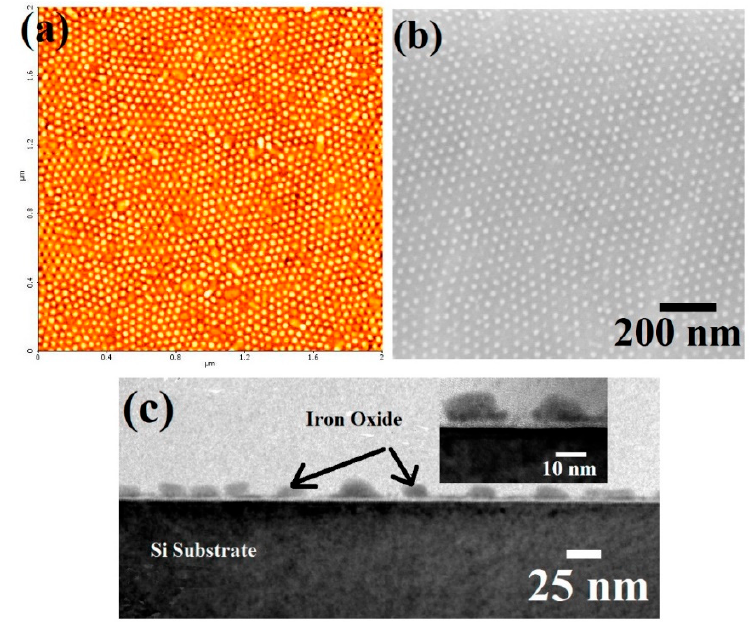
Figure 6. ( a ) AFM ( b ) SEM and ( c ) cross-sectional TEM images of hexagonal ordered iron oxide nanodots after UV/ozone treatment. Inset of ( c ) shows the corresponding higher magnification image.